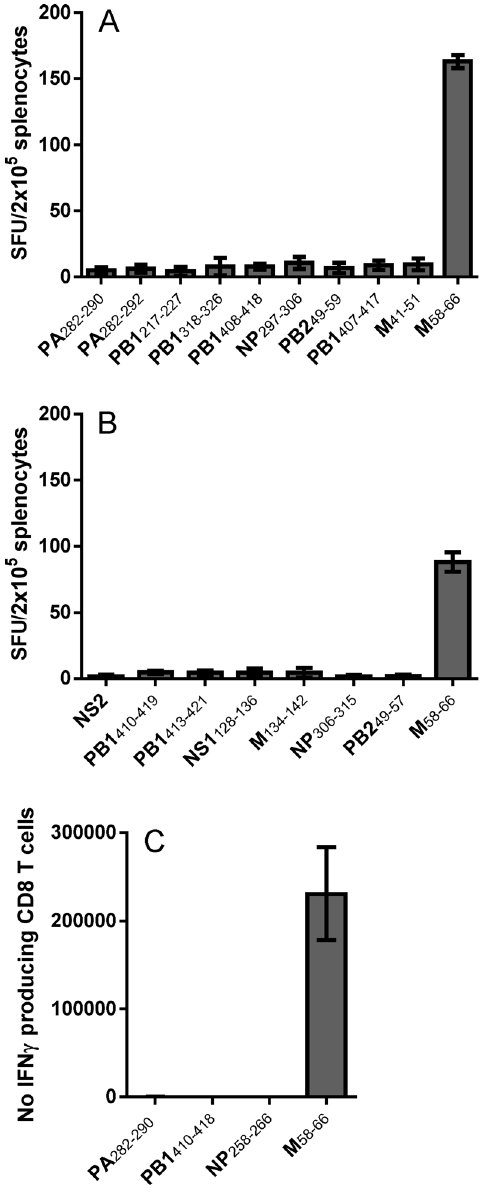
Fig 3. Influenza infected HLA transgenic mice show no reactivity towards any of the immunogenic peptides. HLA transgenic mice were challenged intranasally with 4 LD 50 (B) or 0.4 LD 50 (A and C) of influenza A. IFN γ production from splenocytes was detected 10 days later using IFN γ ELISpot (A and B) or flow cytometry (C). In A and B, each bar represents mean ± SD of IFN γ spot forming units (SFU) of groups of 4 – 5 mice from which splenocytes were pooled before being stimulated ex vivo with peptide in four replicate cultures. In C, each bar represents mean ± SD of the number of IFN γ producing splenic CD8 T cells from 2 individual mice after ex vivo stimulation with peptide. Experiments were conducted 1 – 4 times depending of the peptide. Experiments were conducted 1 – 4 times, depending on the peptide.